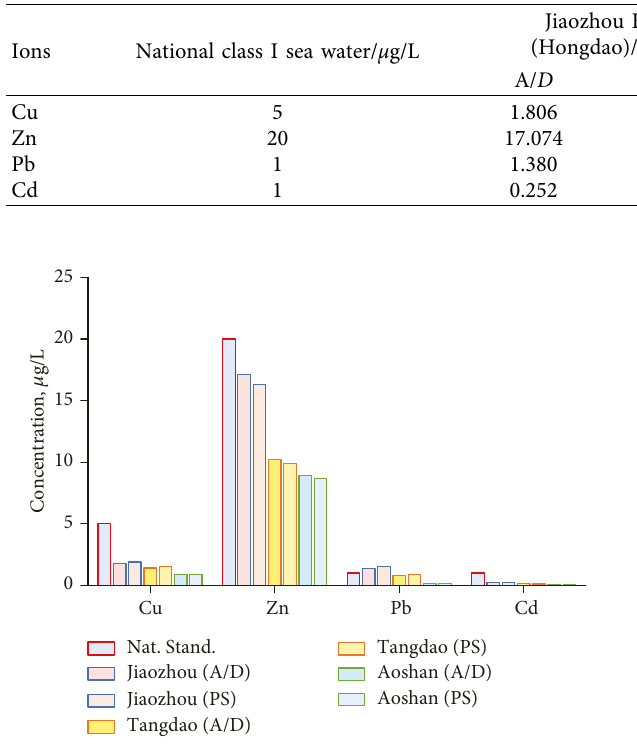
Figure 7: The effect of (a) mass of resin, (b) the flow rate of the sample, and (c) pH of the sample on the test results of trace metals. (d) Repeatability of the enrichment preconcentration column when applying the condition of 12g resin, 0.2mL/min of the flow rate, and pH 7. Table 5: Detection of trace metals of seawaters (Samples taken in Dec. 2021).